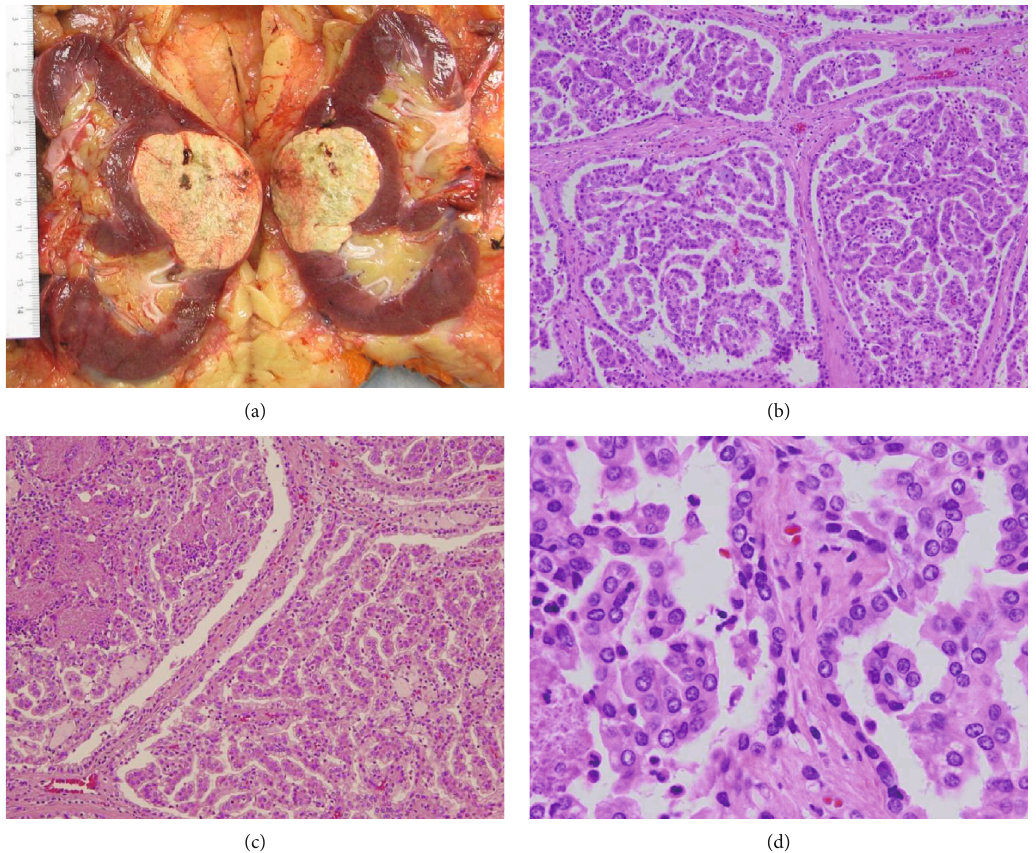
Figure 2: P-RCC gross and microscopic fi ndings: (a) grossly, the tumor is less than 7cm in diameter and con fi ned to Gerota ’ s fascia, making it a stage I tumor. (b) Papillary con fi guration of the architecture, with (c) necrosis intermittently throughout (100x magni fi cation). (d) Pseudostrati fi cation with eosinophilic cytoplasm admixed with foamy histiocytes within a fi brovascular core (400x magni fi cation). These are among the most characteristic features of type 2 papillary renal cell